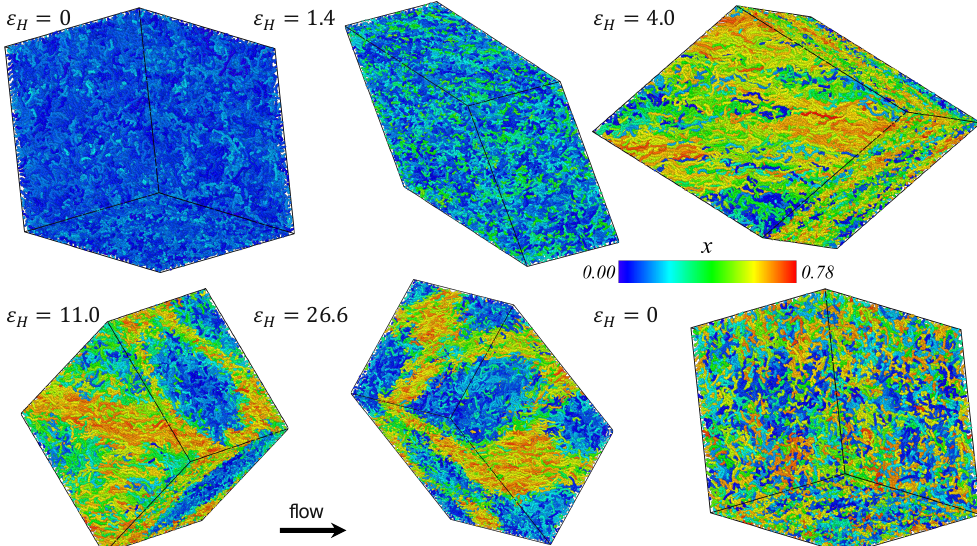
Figure 3. Transient snapshots at various values of Hencky strain of the PE melt undergoing startup of UEF at De = 0.6. Individual macromolecules are assigned a color based on their fractional extension: cooler colors denote relatively coiled chains whereas warmer colors imply stretched chains. The bottom right snapshot is the same as the upper left snapshot corresponding to ε H = 0, except that the colors of the individual molecules are assigned according to the final steady-state extension, not that which they possessed at t = 0. Note that the boxes are displayed at random angles (and sizes) relative to the flow direction because the simulation cell rotates (and elongates/compresses) with time under UEF due to the imposed boundary